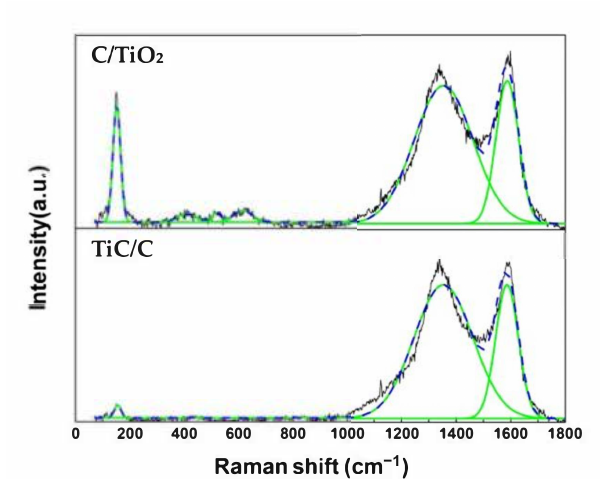
Figure 3. Raman spectra of C / TiO 2 and TiC / C aerogels.